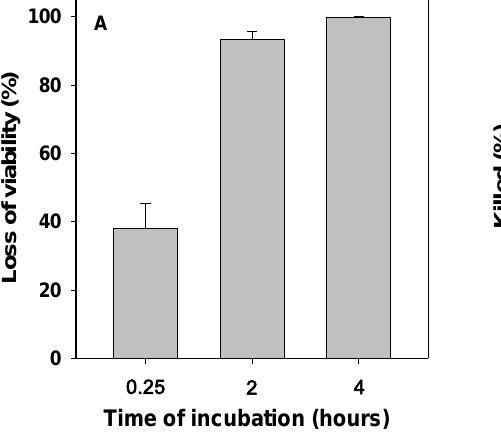
Figure 4. Effect of duration of E. coli exposure to FeTnHex-2-PyP and cell number on cell viability. ( A ) E. coli suspensions in PBS-glucose (~7 × 10 8 cells/mL) were incubated with 5 μM FeTnHex-2-PyP at 37 °C and 200 rpm. At the indicated times, aliquots were properly diluted and plated for counting colonies. ( B ) All conditions were as in Panel A except that cell number varied, but time of incubation was fixed to two hours. Results are presented as mean ± SD.